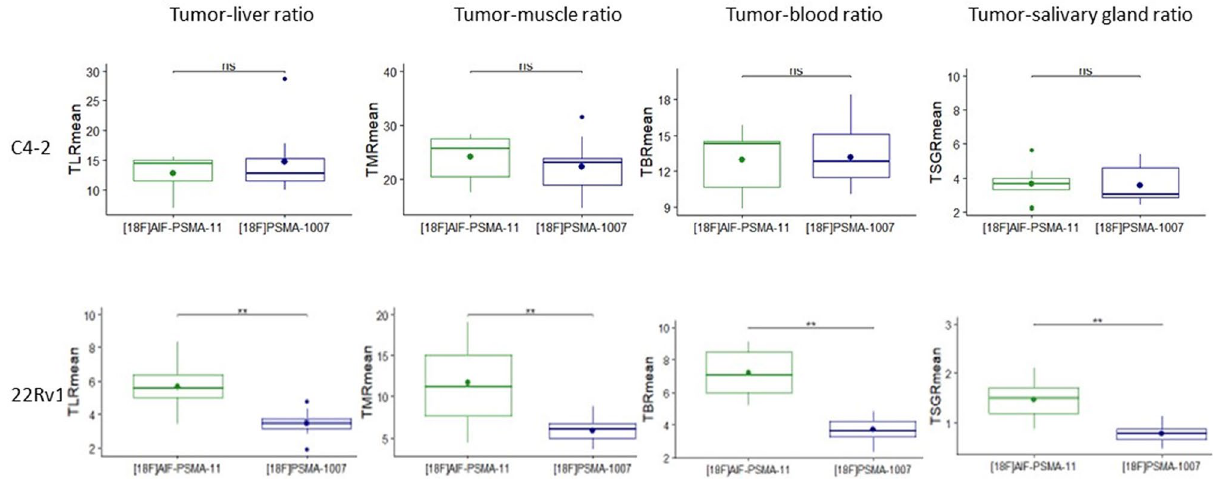
Figure 3. TLR mean (liver), TMR mean (muscle), TBR mean (blood) and TSGR mean (salivary gland) for [ 18 F]AlF- PSMA-11 and [ 18 F]PSMA-1007 uptake in C4-2 and 22Rv1 xenograft bearing mice. The dot presents the mean, the horizontal bar presents the median value. Ns = not significant, * = p < 0.05, ** = p < 0.01.